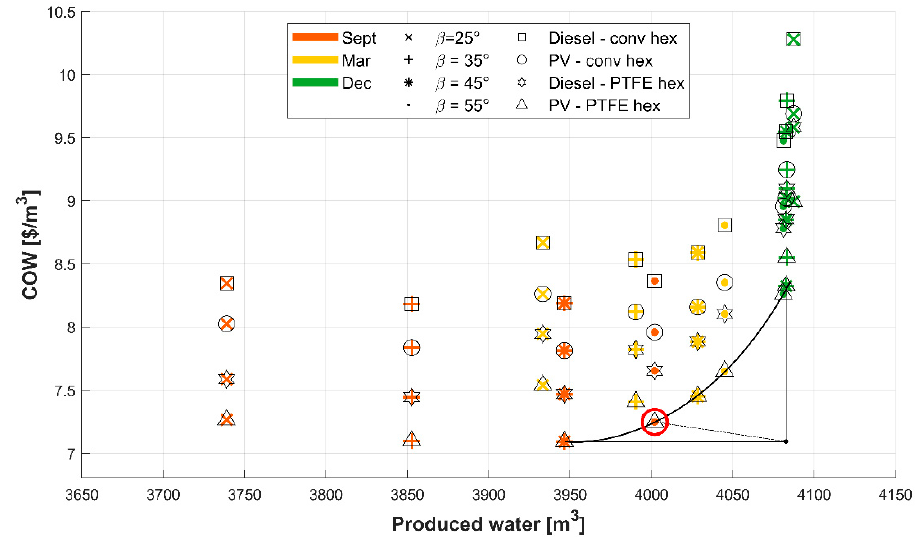
Figure 8. COW versus water production in the year at different design months and β with TBT = 50 °C for different exchangers (conv/PTFE) and a different electrical generation (PV/Diesel) and optimal solutions.